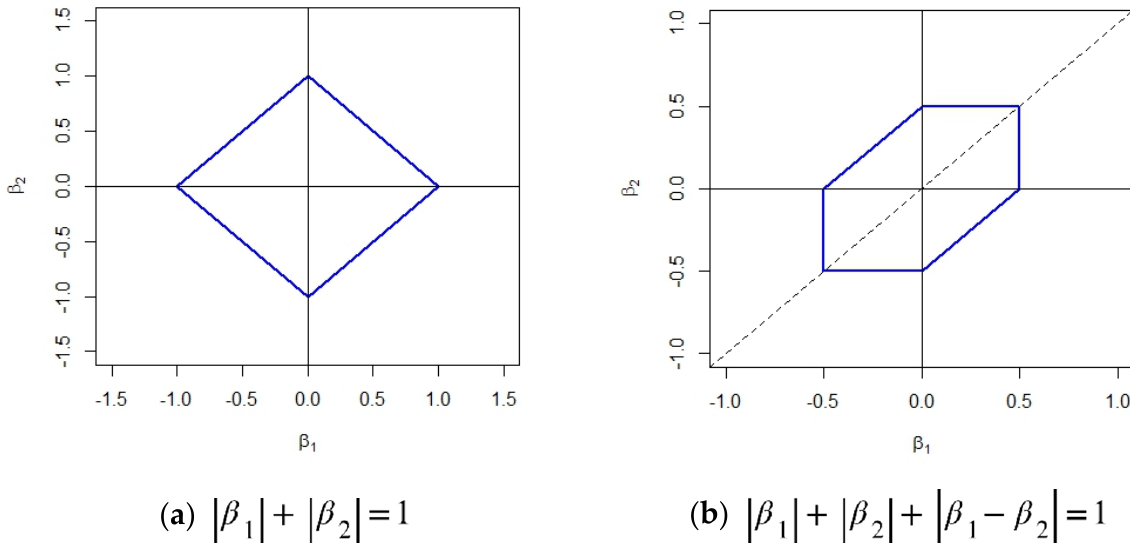
Figure 1. Boundary regions of the constraints: lasso ( a ) and fused lasso ( b ).